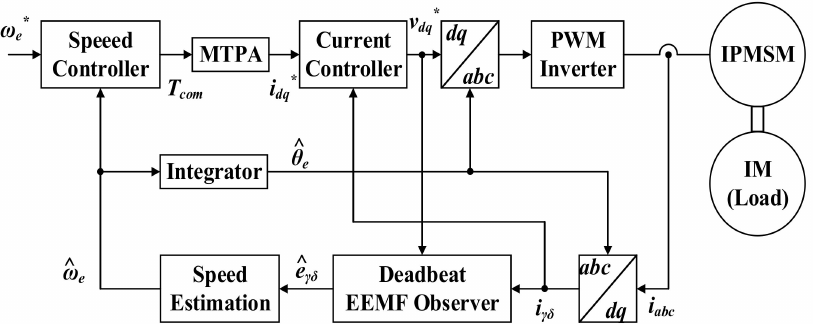
Figure 5. Block diagram of the sensorless speed control system using the proposed deadbeat EEMF Observer.